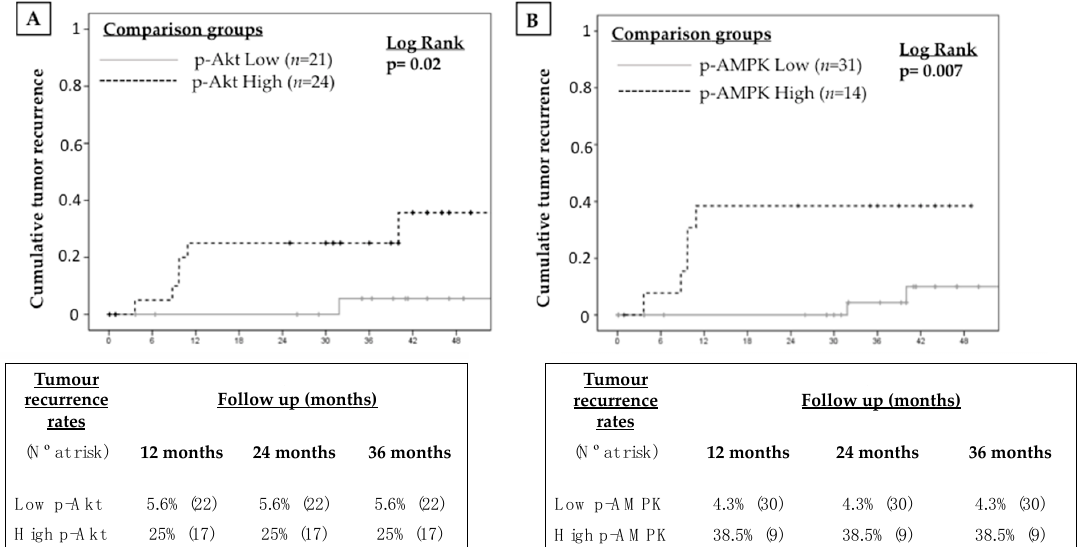
Figure 3. Kaplan-Meier curve showing the impact of intra-tumour p-mTOR expression on the recurrence of hepatocellular carcinoma after liver transplantation.